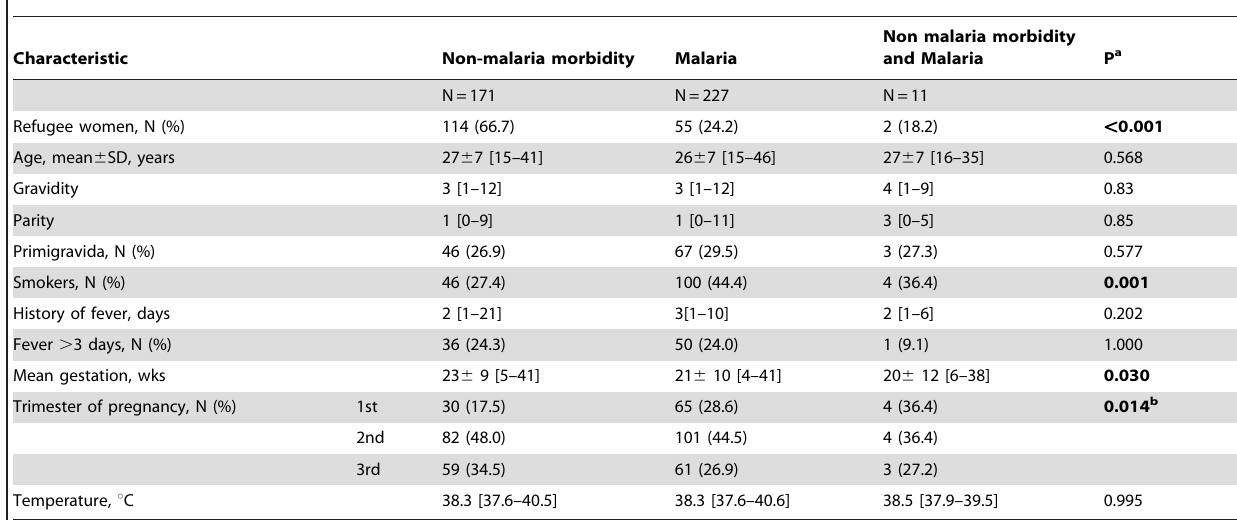
Table 1. Characteristics at baseline of febrile pregnant women with malaria and non-malaria morbidity.